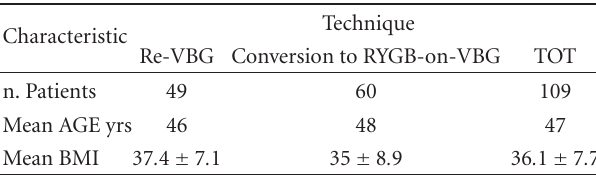
Table 1: Revisionary surgery for failed or complicated VBGs: patient characteristics.